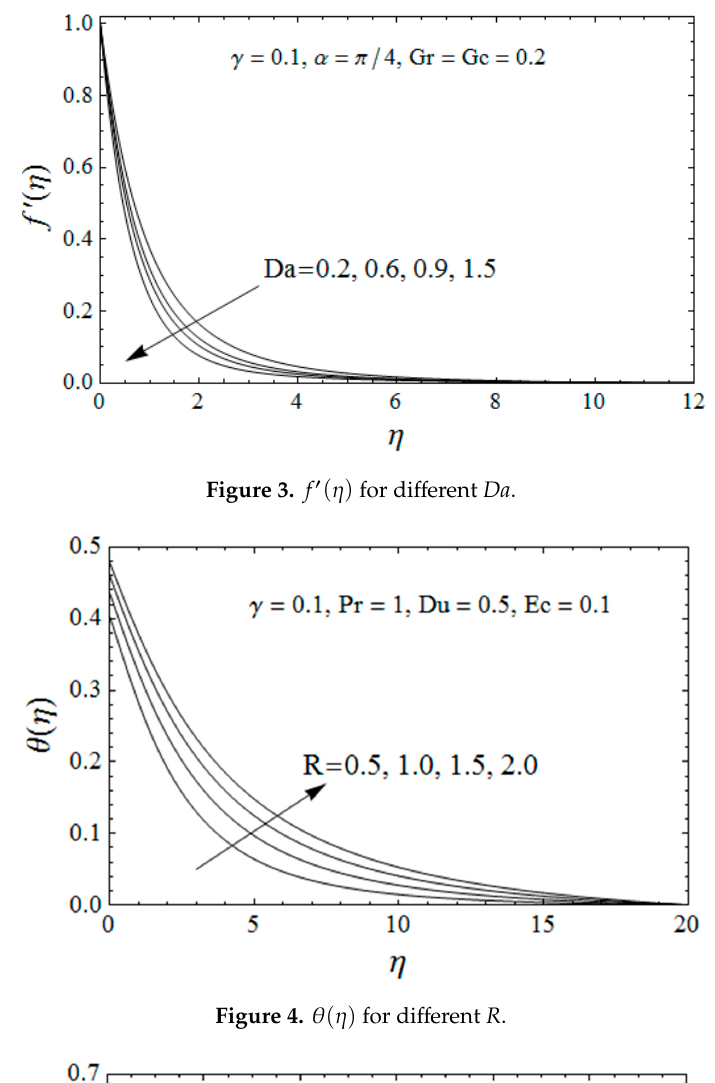
Figure 2 . 𝑓′(𝜂) for different 𝛾.